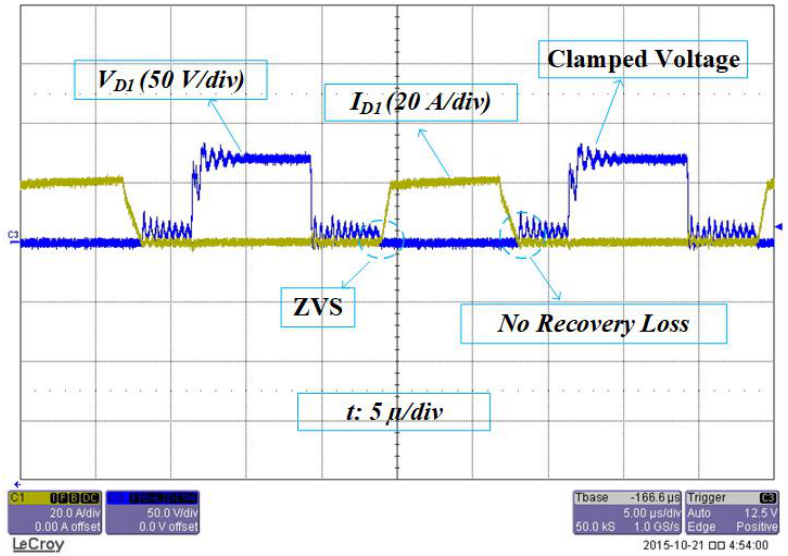
2 at 100% of load.